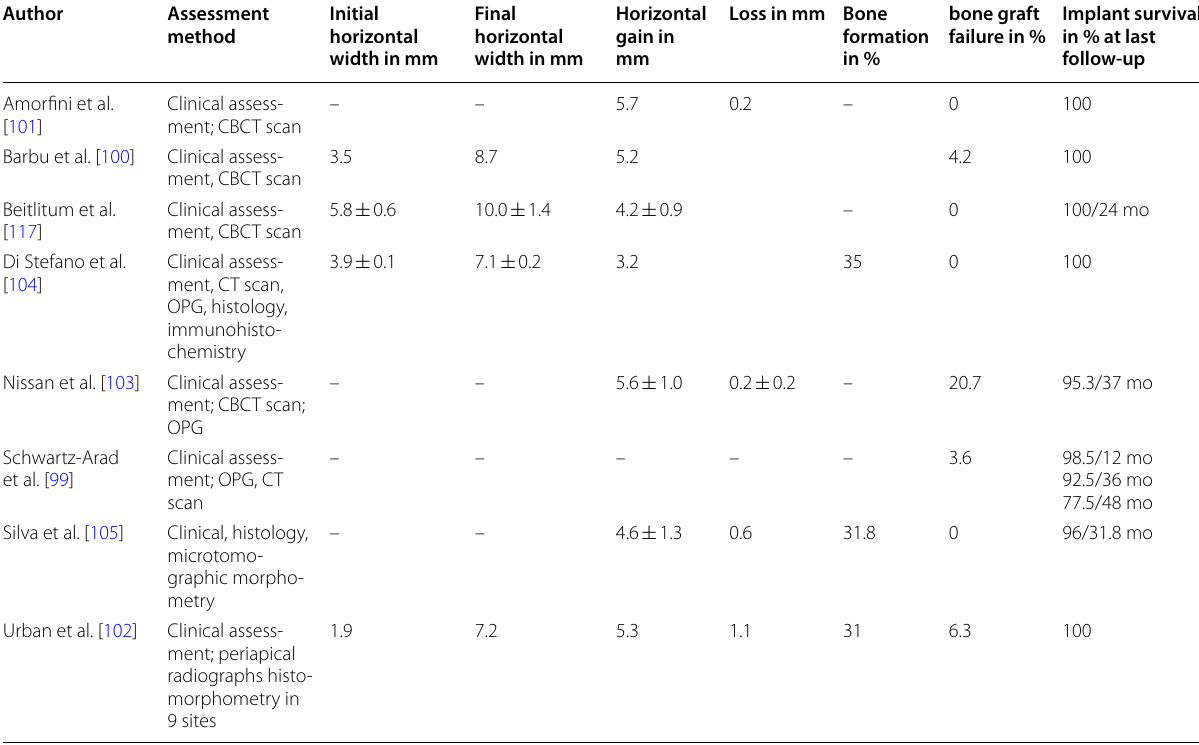
Table 4 Assessment parameters and study